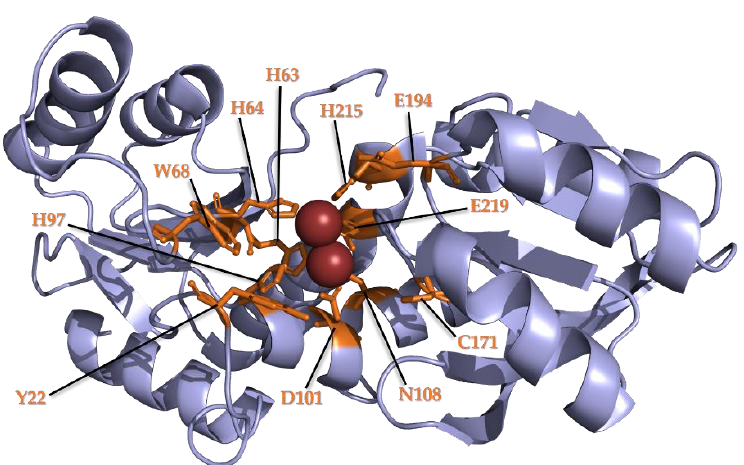
Figure 1. Dinuclear metal-binding site of the E. coli DUF34 homolog, YbgI. The crystal structure of YbgI (DUF34 homolog, E. coli ) illustrates conserved residues of the protein family specific to the monomeric cleft of the active site and its dinuclear metal center. There are highly conserved residues noted by Ladner et al. [26] to demonstrate involvement in the structure of the binding pocket that are distinctively colorized, annotated (orange; residue identity and location labeled accordingly).